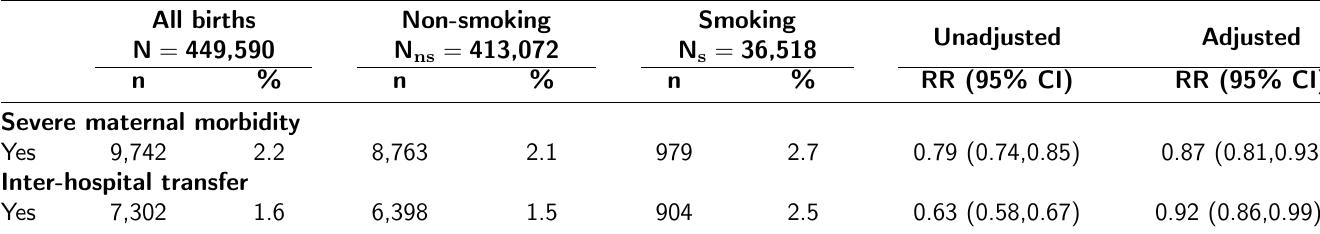
Table 2: Frequencies of maternal outcomes at the time of birth by smoking status during pregnancy All births